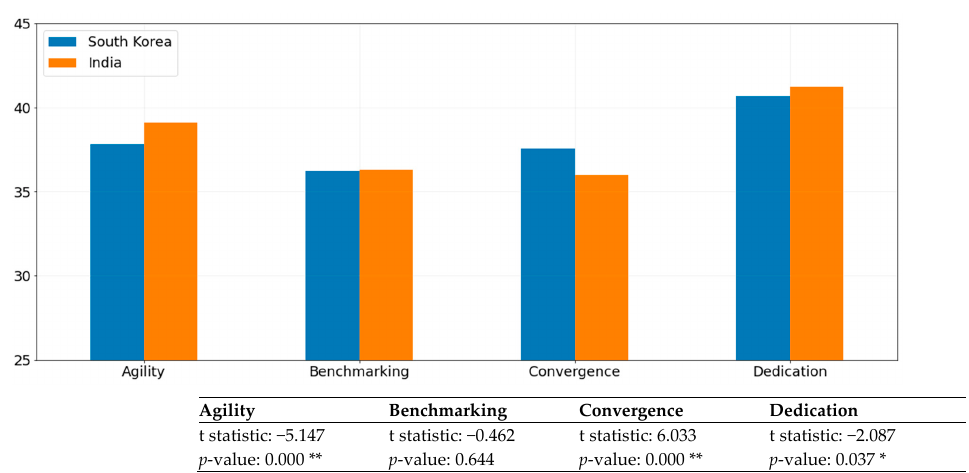
Figure 3. Average similarity scores for four factors.